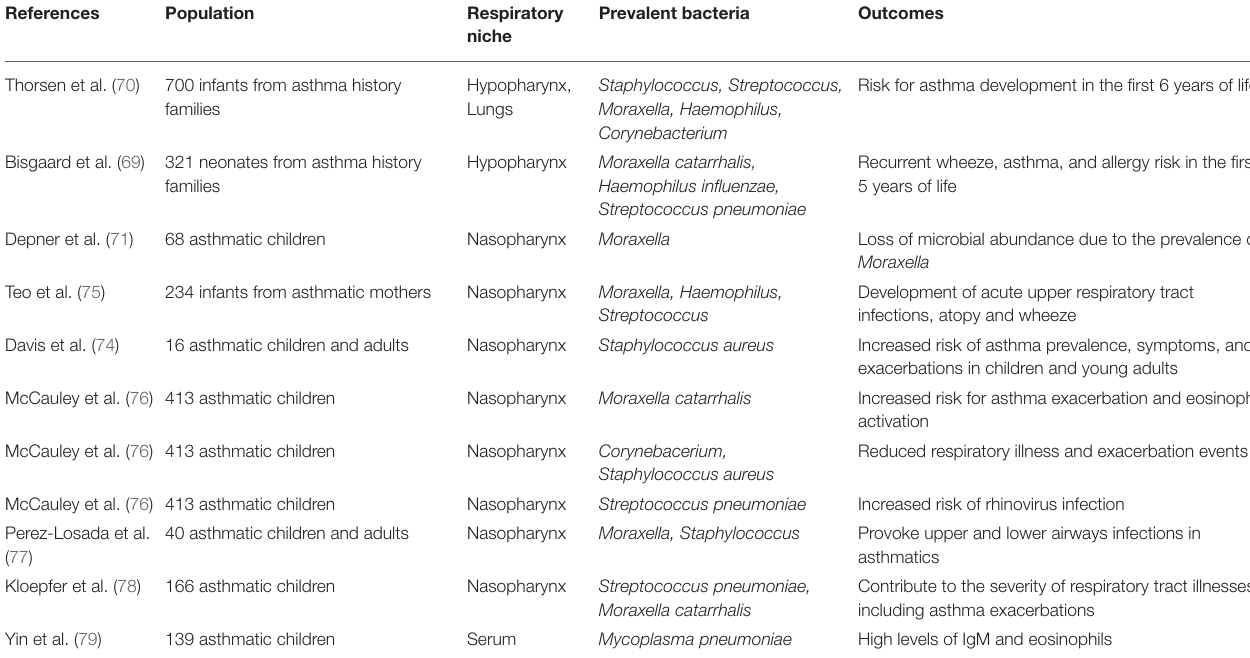
TABLE 1 | Studies of the microbiome profiles of asthmatic infants and children and the assessment of the role of each prevalent bacterium in asthma